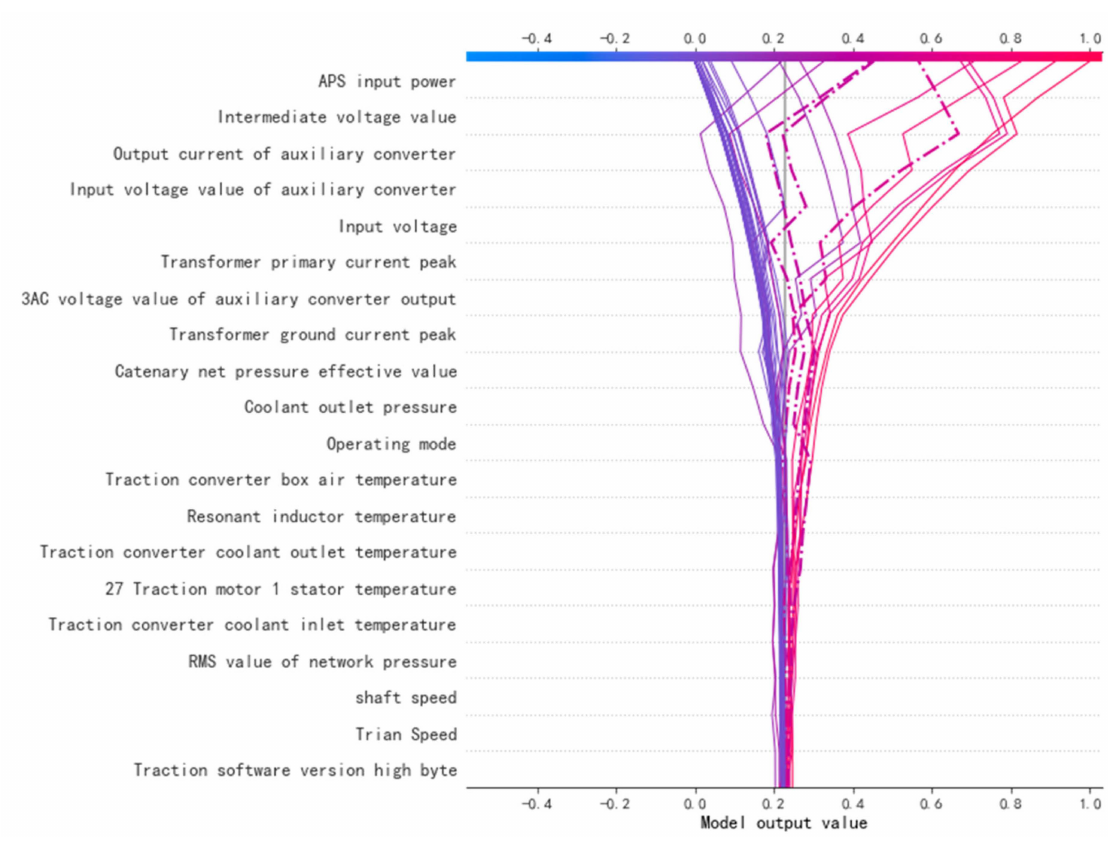
Figure 10. Visual illustration of the decision path of each sample based on the SHAP value of each feature contribution.